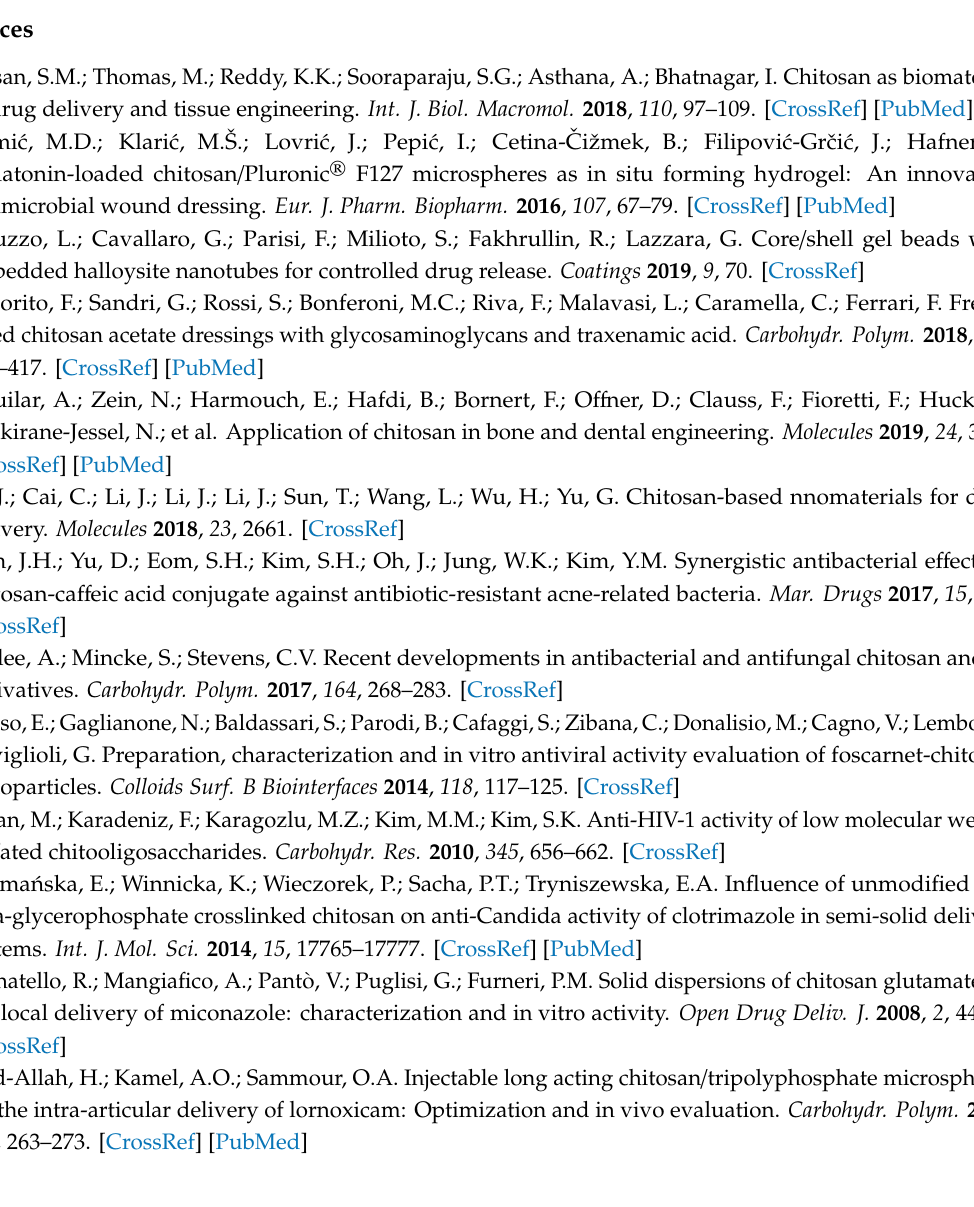
Figure S1: SEM image of zidovudine-free (placebo) microparticles with chitosan glutamate and beta-glycerophosphate disodium in a ratio of 2:1 ( w / w